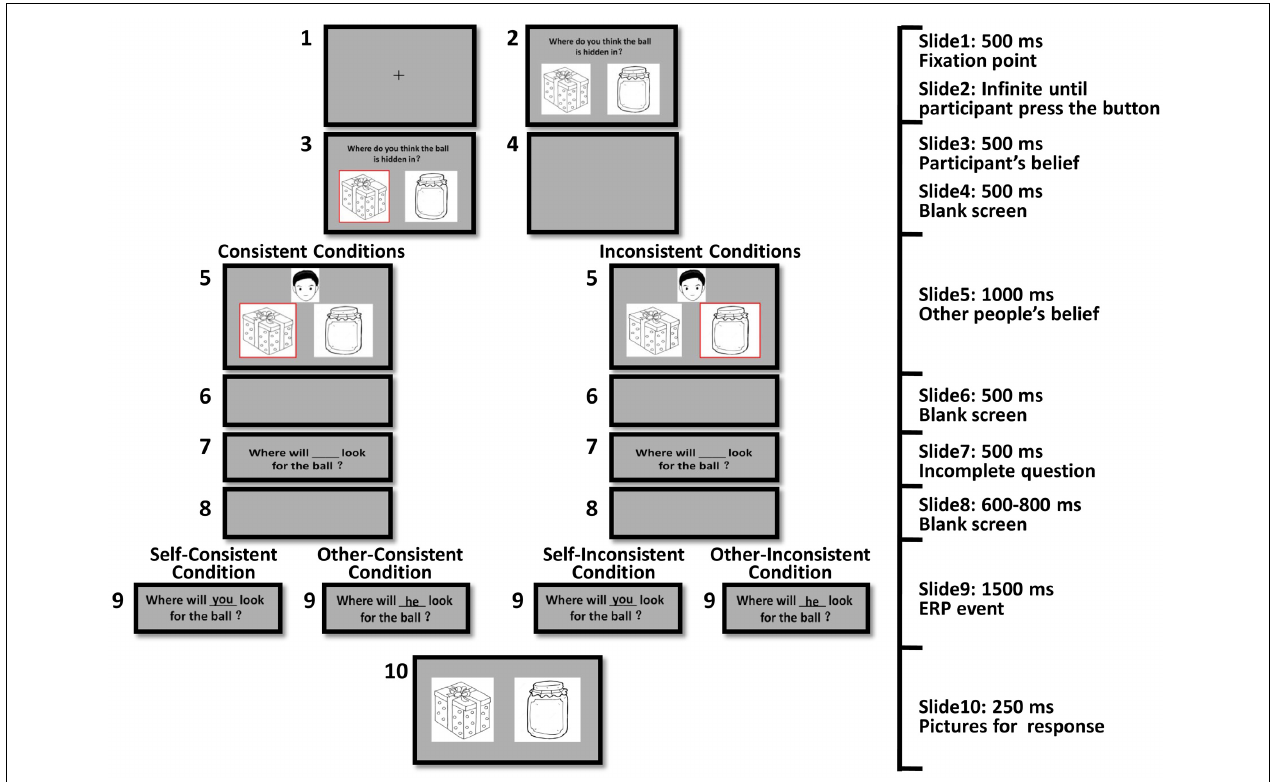
FIGURE 1 | Experimental